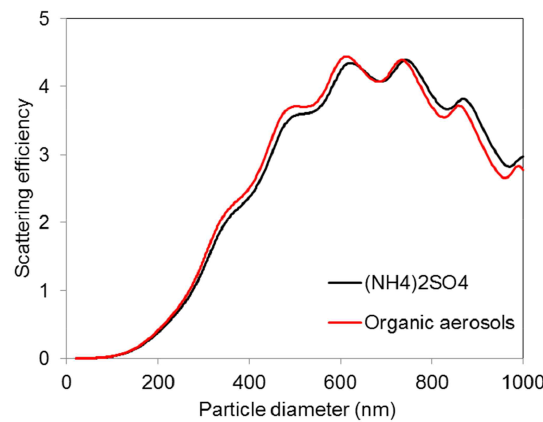
Figure 10. Scattering efficiency of (NH 4 ) 2 SO 4 and organic aerosols as a function of particle diameter, as calculated from Mie